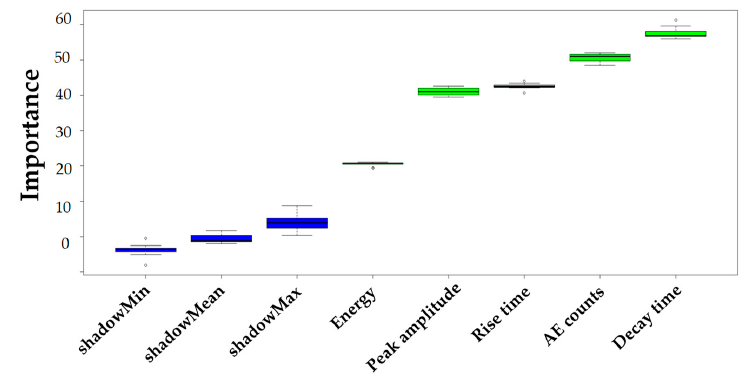
Figure 11. Ranking the features using the Boruta algorithm.